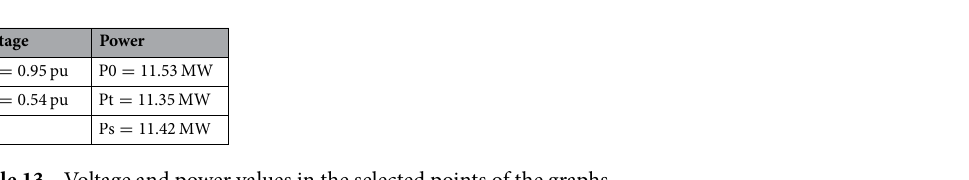
Table 13. Voltage and power values in the selected points of the